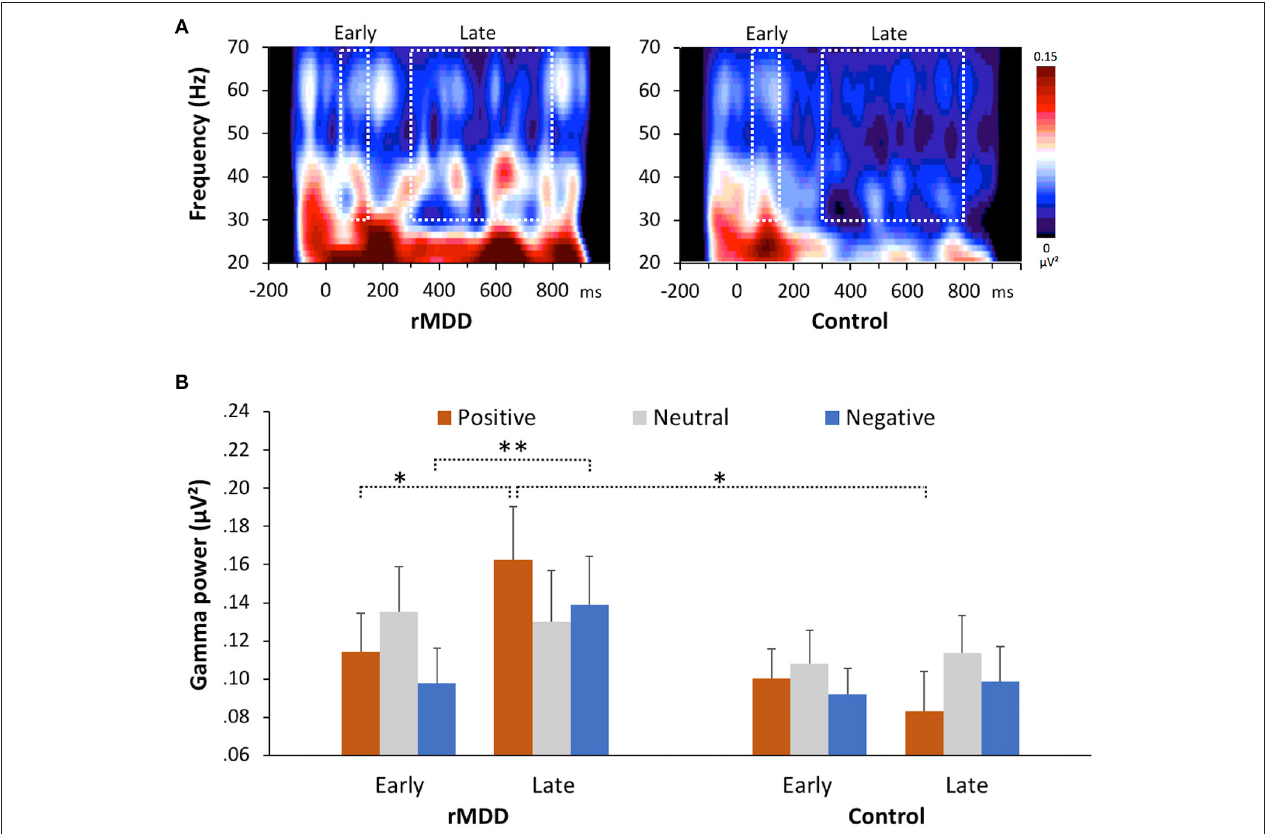
FIGURE 1 | Group differences in gamma-band responses during the emotional valence identification task. (A) Wavelet decomposition for both groups showing the response to positive words at all frequencies at electrode F4. (B) Early and late gamma powers for all valences in the two groups. Error bars indicate the standard error. * p < 0.05, ** p < 0.01,